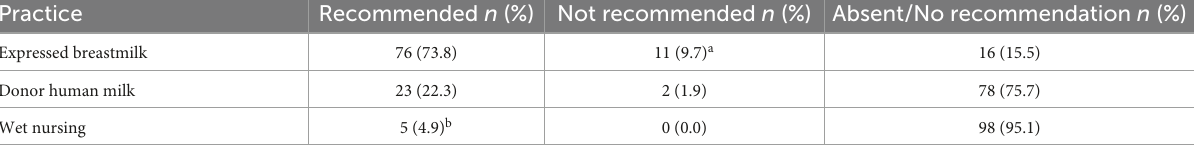
TABLE 2 Number and frequency of guidance documents recommending, not recommending, and providing no recommendation on alternative feeding methods of expressed breastmilk, donor human milk, and wet nursing ( N =